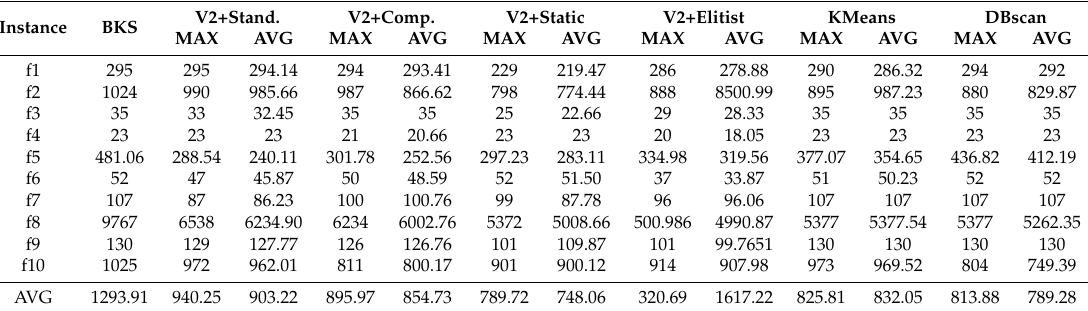
Table A17. CSA/KP—VShape 2—Two-steps vs. KMeans vs. DBscan.